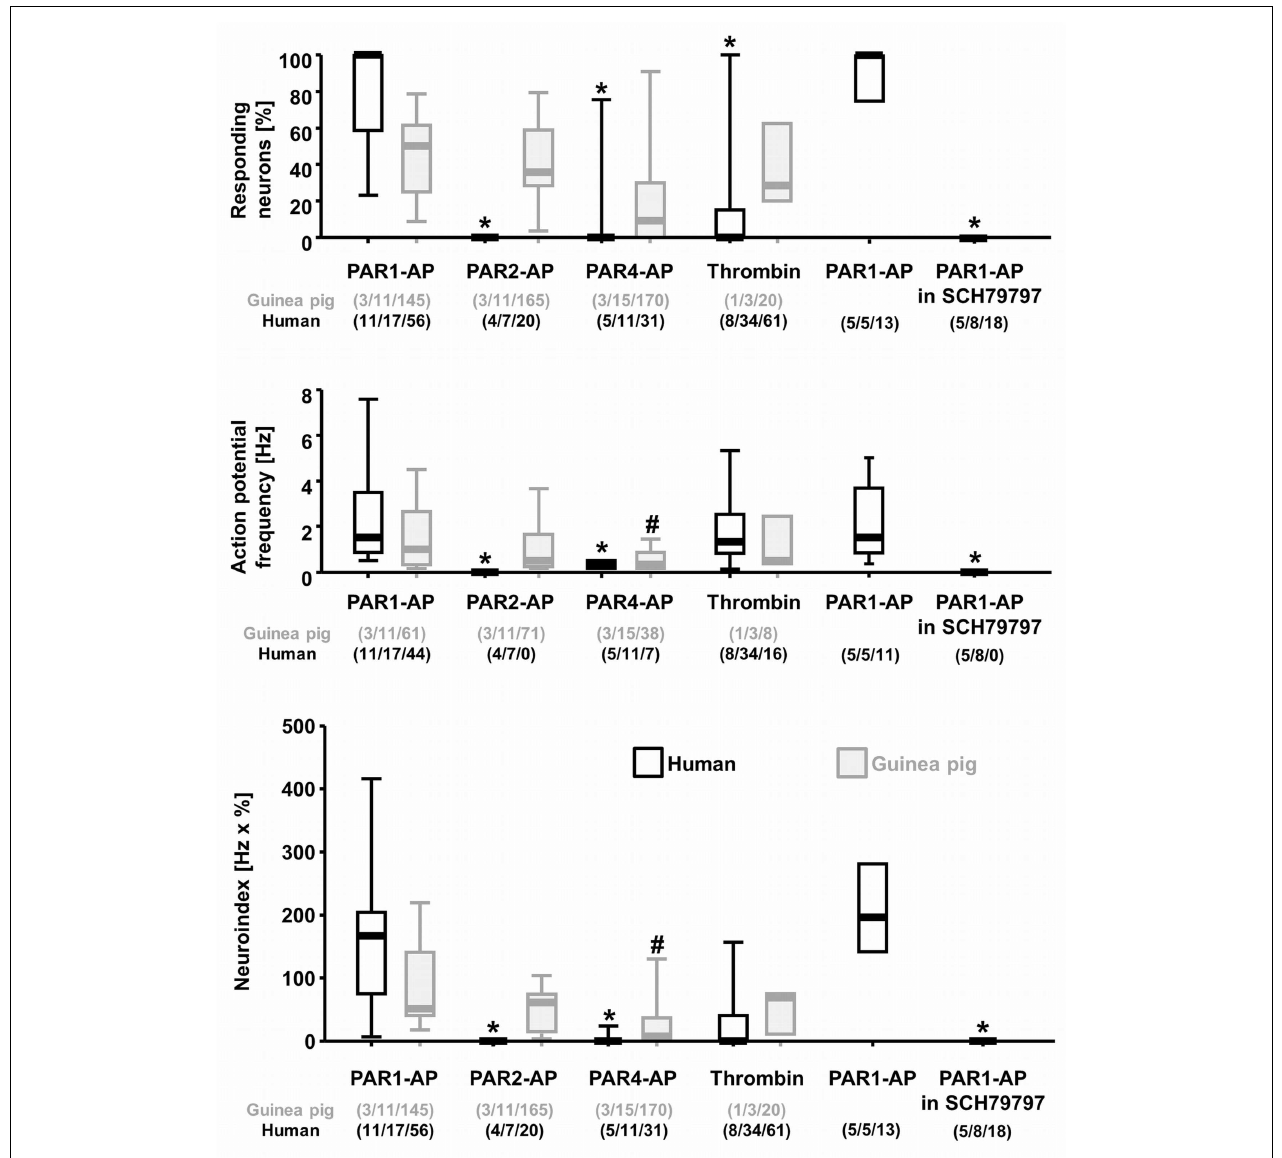
response.Thrombin also activated human myenteric neurons but to a lesser degree than PAR1-AP.The PAR1-AP effect in human neurons is blocked by the specific PAR1 antagonist SCH79797. In guinea pig myenteric neurons the responsiveness to PAR1-AP, PAR2-AP, and thrombin was similar, but PAR4-AP evoked a spike discharge in less neurons at a significantly lower frequency. *Indicates significant differences to PAR1-AP in human neurons; # indicates significant differences to PAR1-AP in guinea pig neurons. Numbers in parenthesis indicate numbers of